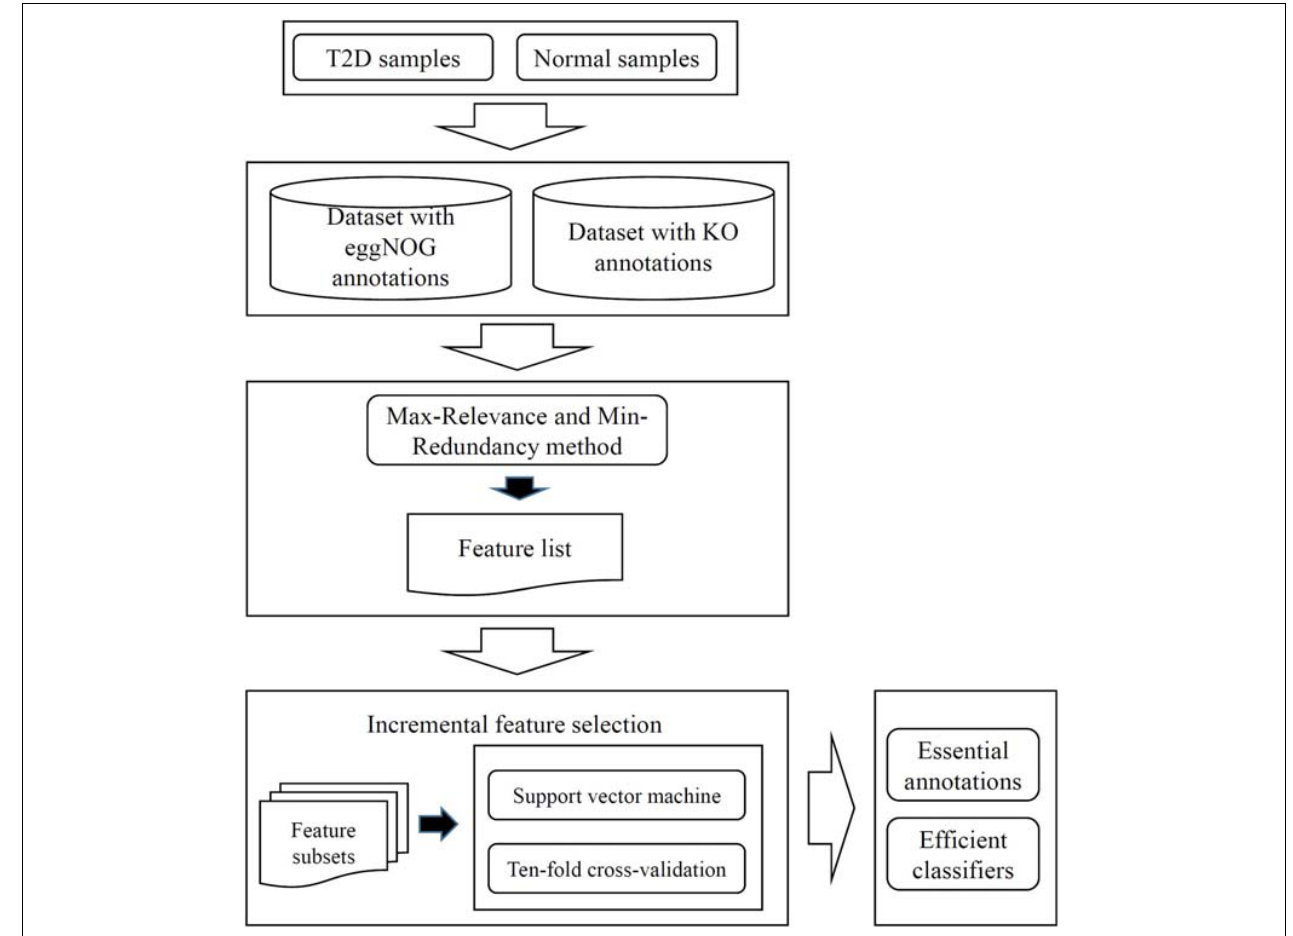
FIGURE 1 | Entire procedures to investigate the T2D datasets with eggNOG or KO annotations. The dataset is first analyzed by the Max-Relevance and Min-Redundancy method, resulting in a feature list. This list is fed into the incremental feature selection method, incorporating support vector machine as the classification algorithm, to extract essential annotations and construct efficient